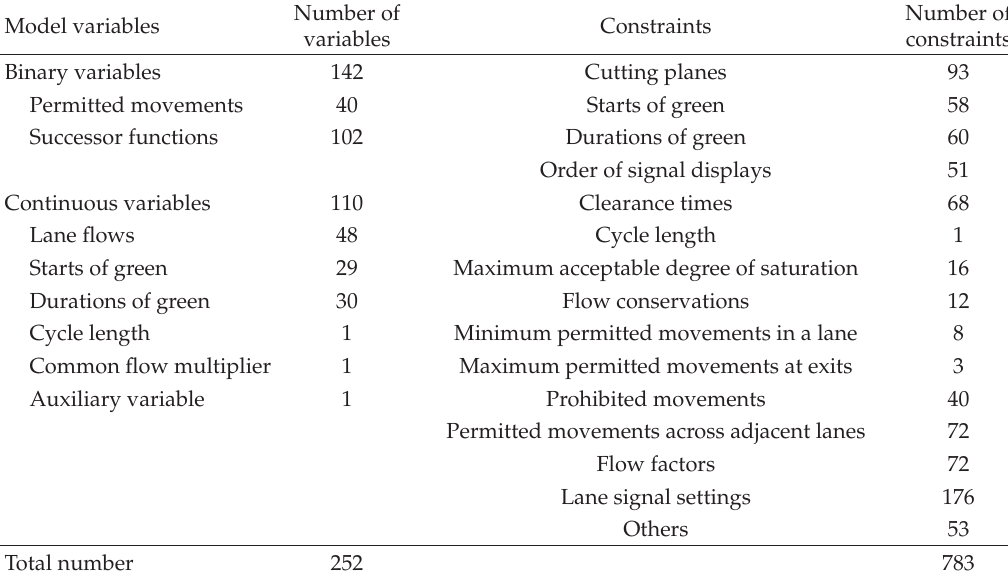
Table 3: Statistics of the example